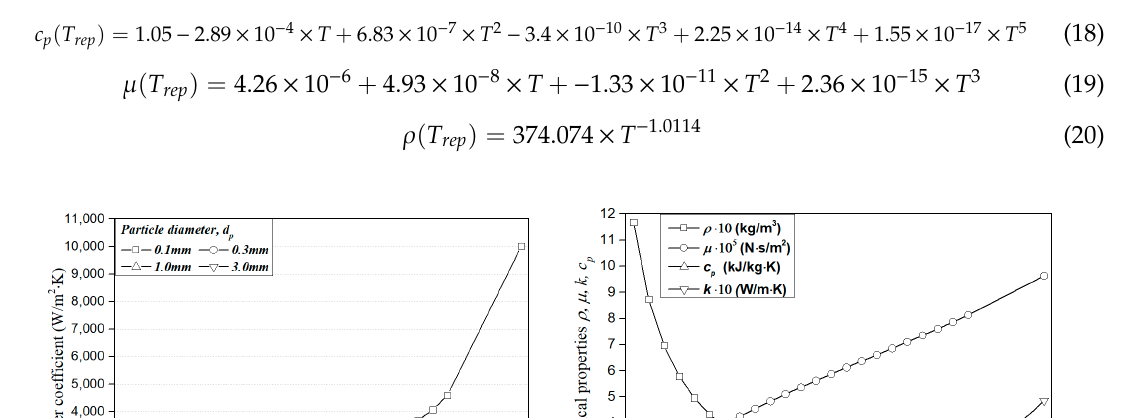
Figure 10. Effects of the heat transfer coefficient of the maximum particle dimeter and velocity